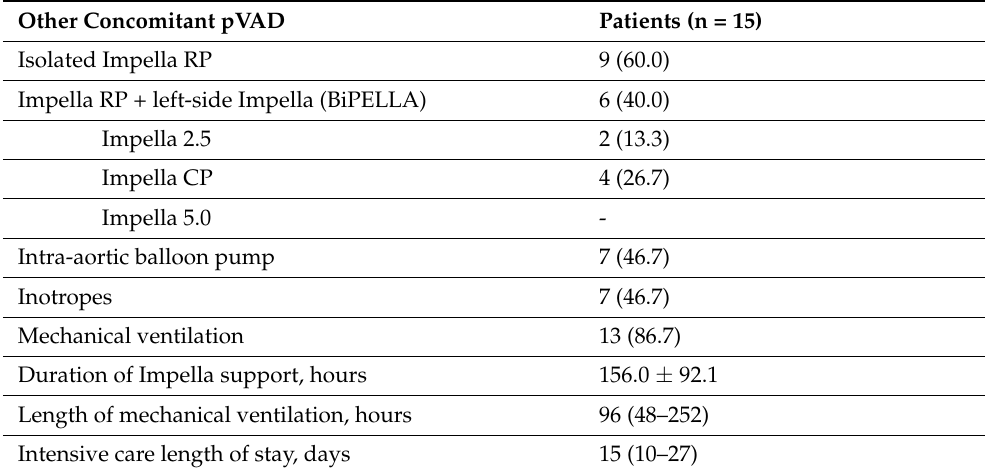
Table 2. Clinical course and procedural characteristics.